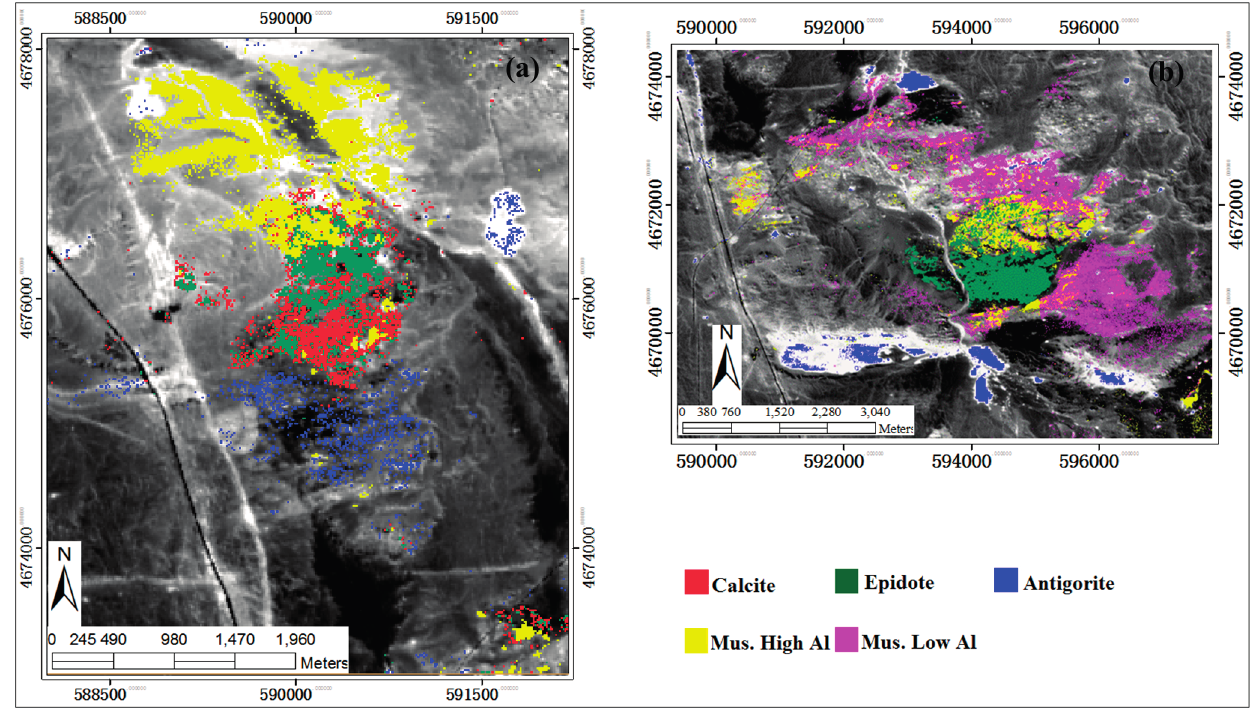
Figure 7. Mineral information extraction with the application of the SAI model and spectral absorption features from the HyMap data. ( a ) Mineral mapping of the gold-mine area ( b ) Mineral mapping of the copper-mine